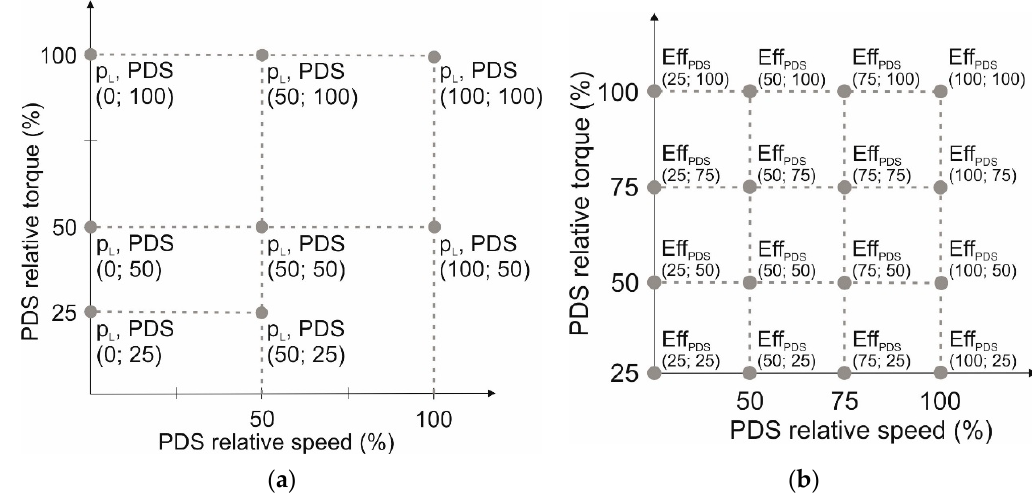
Figure 3. Data formats for PDS efficiency interpolation: ( a ) Siemens (losses according to IEC 61800-9-2:2017 [40]; source: Sinasave software [43]); ( b ) ABB (efficiency; source: manufacturer’s statements [44,45]).